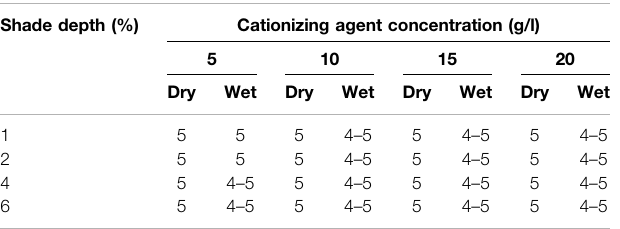
TABLE 5 | Colorfastness to rubbing (dry and wet) results recorded according to the ISO 105-X12:2001(E) standard protocol for cationized cotton dyed